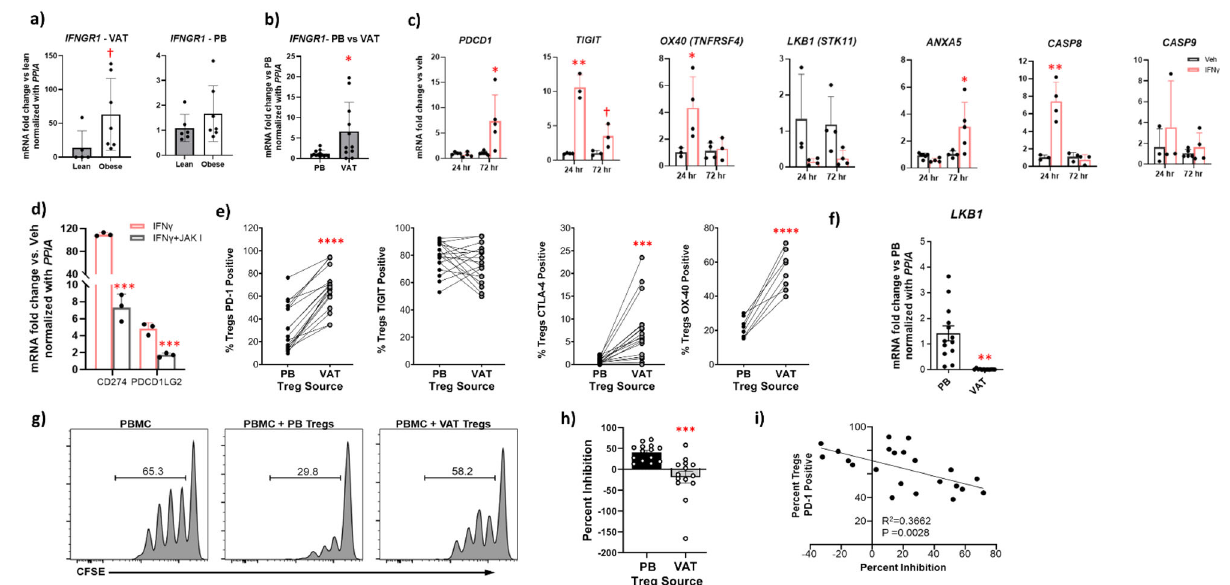
Fig. 5 | Interferon gamma mediates an exhausted human regulatory T cell phenotype.a Geneexpressionofinterferongammareceptor1( IFNGR1 )inisolated humanregulatory Tcells(Tregs) from visceraladipose tissue (VAT)and peripheral blood(PB)ofleanversusobesesubjects(VAT: N =5lean, N =7obese;PB: N =6lean, N =7obese). b Geneexpressionof IFNGR1 inisolatedhumanTregsfromVATvs.PB. c Gene expression of programmed cell death protein 1 ( PDCD1 or PD-1 ), T cell immunoreceptorwithIgandITIMdomains( TIGIT ), OX40 , LKB1 ,Annexin5( ANXA5 ), and Caspase ( CASP ) 8 and 9 in isolated human PB Tregs ( N =4 per group) cultured for 24hr and 72hr, with or without recombinant IFN γ (20ng/ml); ** P <0.010; * P <0.05. d GeneexpressioninhumanculturedsubcutaneousadipocytesofthePD- 1 ligands PD1GL1 ( CD274 ) and PDCD1LG2 . Adipocytes were pretreated with a JAK inhibitor (JAK I) for 1.5hr in adipocyte maintenance medium prior to co-treatment with IFN γ (20ng/ml) for 48hr ( n =3). Fold changes vs. vehicle samples are not showninthegraphand allclose to1;*** P <0.001. e